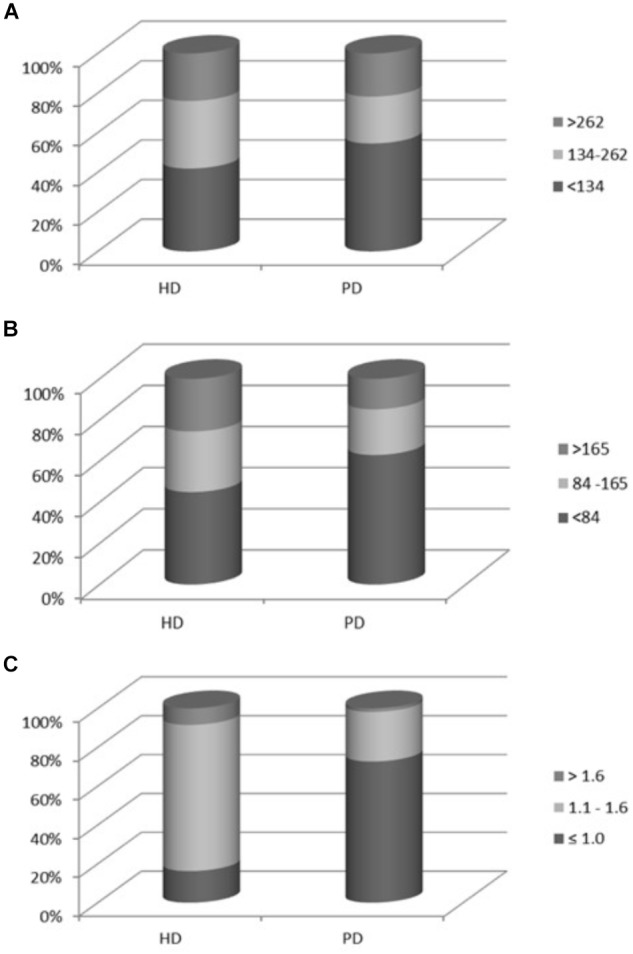
Diagnosis of bone turnover in dialysis according to: (A) KDOQI recommended cut-off levels for iPTH Scantibodies assay normalized according to Soubervielle to obtain the equivalent Allegro iPTH values. [HTBD: iPTH Scantibodies > 262 pg/ml = Allegro iPTH > 300 pg/ml; NORMAL: iPTH Scantibodies 134–262 pg/ml = Allegro iPTH 300-150 pg/ml; LTBD: iPTH Scantibodies < 134 pg/ml = Allegro iPTH < 150 pg/ml]. (B)
Whole 1-84 PTH assay normalized according to Soubervielle to obtain the equivalent Allegro iPTH values. [HTBD: whole 1-84 PTH > 165 pg/ml = Allegro iPTH > 300 pg/ml; NORMAL: whole 1-84 PTH: 84–165 pg/ml = Allegro iPTH 300–150 pg/ml; LTBD: 1-84 PTH < 84 pg/ml = Allegro iPTH < 150 pg/ml]. (C)
1-84 PTH/
non-1-84 PTH ratio < 1.0 combined with iPTH level < 420 pg/mL for developing LTBD and a ratio > 1.6 combined with iPTH 340–790 pg/mL for risk of HTBD. Prevalence of LTBD in PD (72.7%) vs. HD patients (16.3%), P < 0.0001. HD, hemodialysis; PD, peritoneal dialysis, HTBD, high turnover bone disease; LTBD, low turnover bone disease.